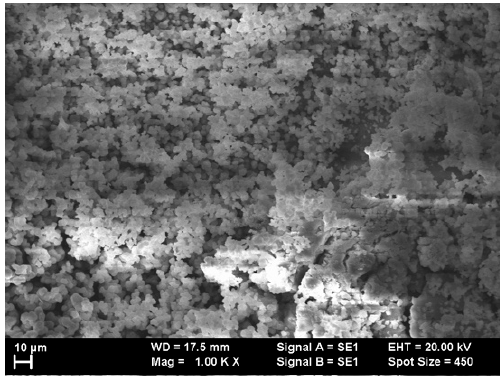
Figure 1. SEM image of Mn 53 Al 45 C 2 as-cast sample.